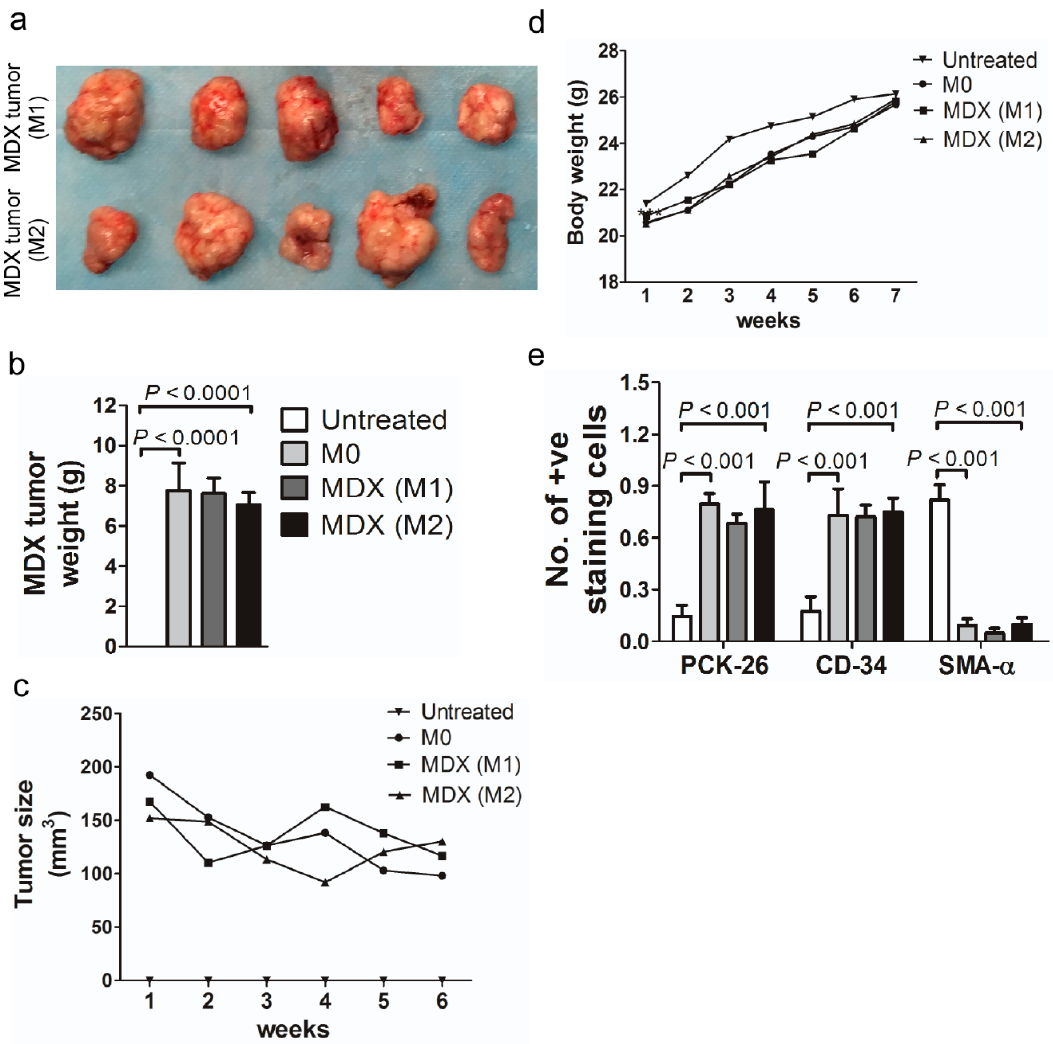
Figure 4. Mouse-derived xenograft model (MDX) to study the effect of combined treatment with capsaicin and H. pylori . ( a ) Macroscopic analyses of tumor tissue. Tumor images of first (M1) and second passage (M2) tumors showed a high growth rate in SCID mice. Tumors from mice treated with capsaicin and infected with H. pylori are represented as M0. The M1 and M2 tumor tissues were similar to M0 in ( b ) weight and ( c ) volume (mm 3 ). ( d ) Bodyweight in grams measured per week. Mice were weighed before treatment (week 0) and then twice per week for 7 weeks. Mice with M0, M1, and M2 tumors lost weight compared to untreated control mice ( n = 5/cohort). ( e ) Histological analyses of tumor tissues from mice treated with a combination of capsaicin and H. pylori (M0) with first (M1) and second passage (M2) xenografts. Histochemical analysis of PCK-26 and CD-34 in mouse tumor tissue (MDX) showed strong staining compared to the weak staining of SMA- α . A score of 1 denotes the highest staining and expression, whereas a score of 0 indicates negative staining or no expression. Quantitative immunohistochemistry of PCK-26 and CD-34 exhibited high scores in tumor tissues compared to a low score for SMA- α